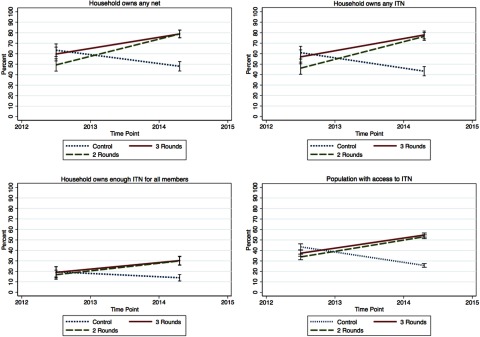
Trends in ITN Indicators From Baseline to EndlineAbbreviation: ITN, insecticide-treated net.